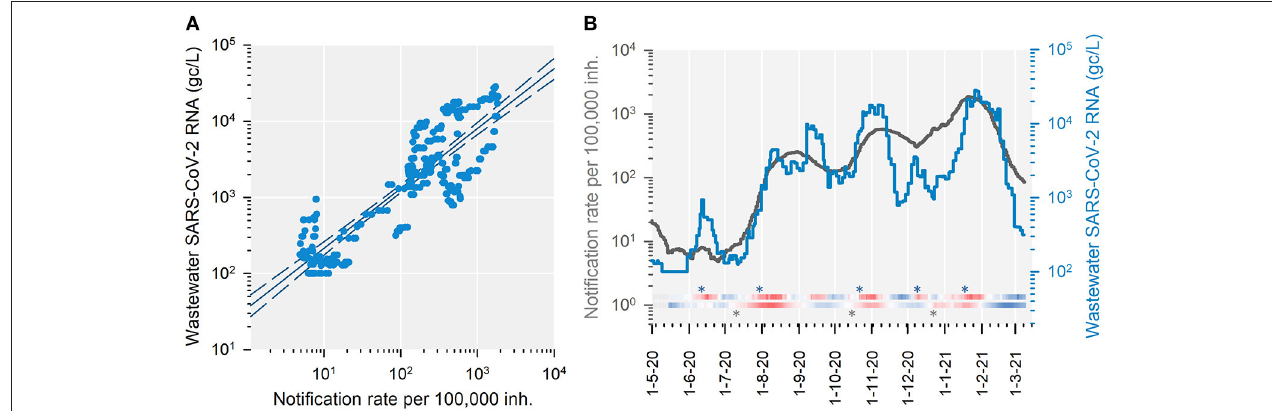
FIGURE 4 | SARS-CoV-2 wastewater signal from a second treatment plant vs. notification rates over 14-day periods. Average log SARS-CoV-2 RNA concentrations in wastewater from Quart-Benàger WWTP and cumulative case notification rates per 100,000 inhabitants are shown. These variables were calculated for each of 301 periods of 14 days using a one-day shifted sliding windows. (A) Least-squares log-log linear regression, showing 99% confidence intervals (y = 0 · 785 x + 1 · 547, r 2 = 0 · 753). (B) Time series. The heat maps below the curves show the difference between consecutive 14-day periods (red: increasing, blue: decreasing) for wastewater data (top) and notification rates (bottom). Asterisks indicate the first day in which a significant increase between two consecutive 14-day periods was detected.